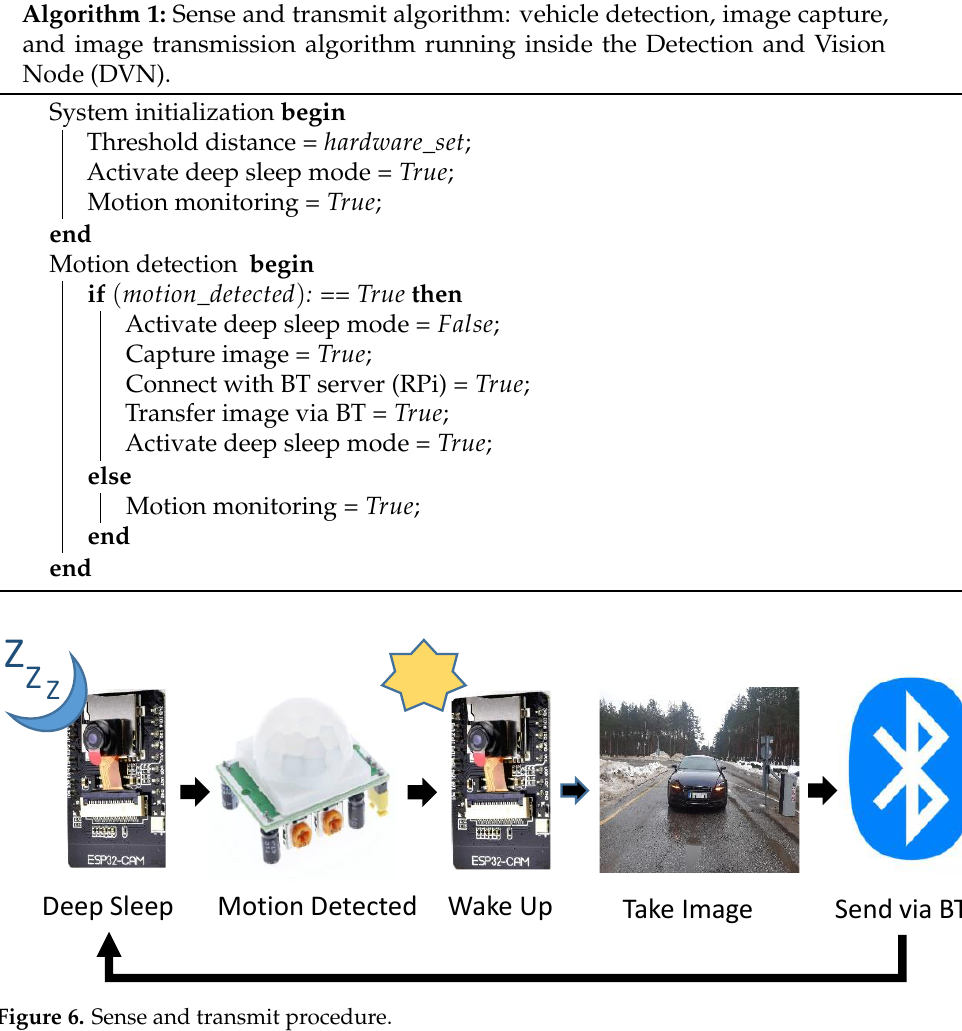
Figure 6. Sense and transmit